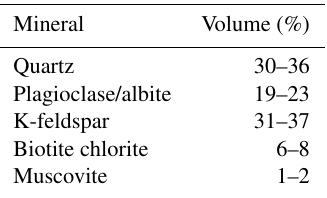
Table 4. Mineralogical composition of the FEBEX granite (after Missana and Garcia-Gutiérrez,